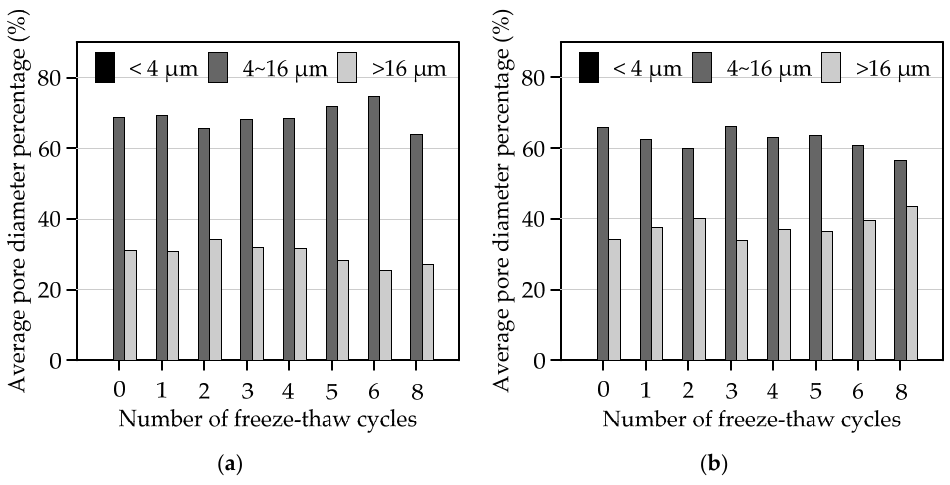
Figure 13. Percentage of D h under F-T cycles: (a) S0 and (b) S2.